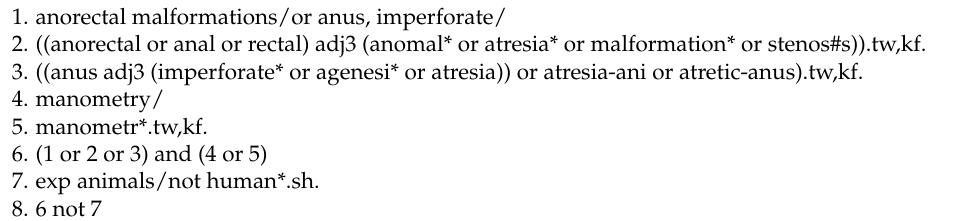
Table A1. Sample search strategy: MEDLINE.